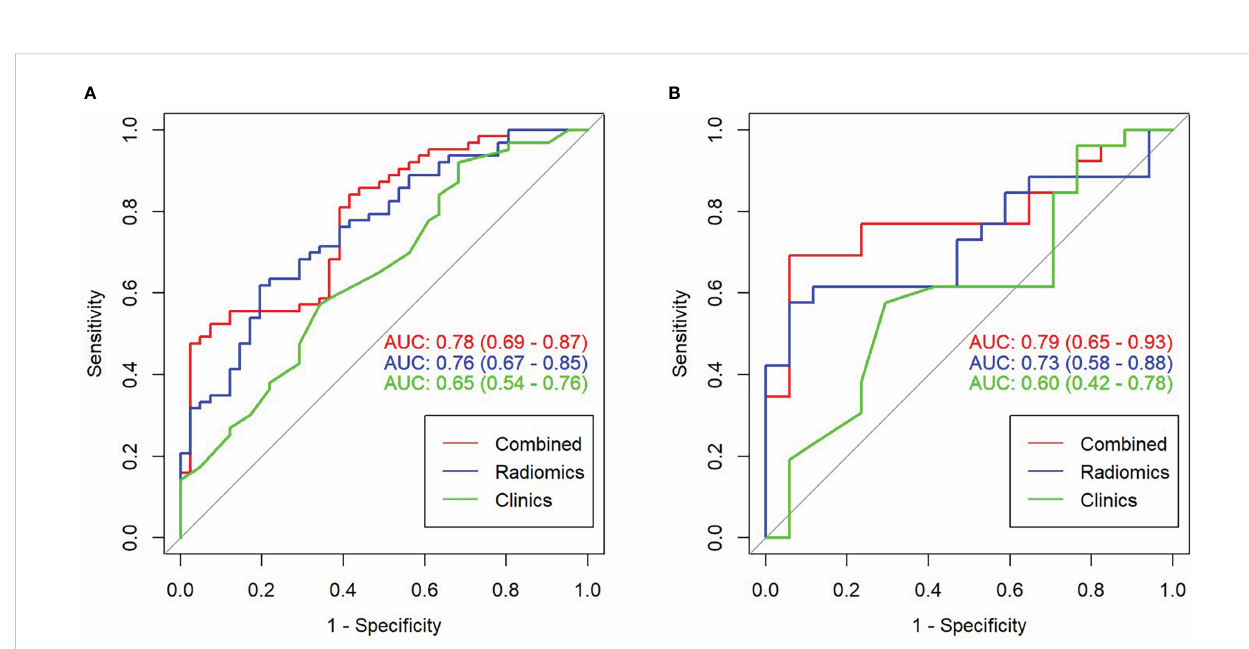
FIGURE 2 Receiver operating characteristic (ROC) curve comparison of combined and radiomics and clinical models. (A) ROC curve in the training set. (B) ROC curve in the validation